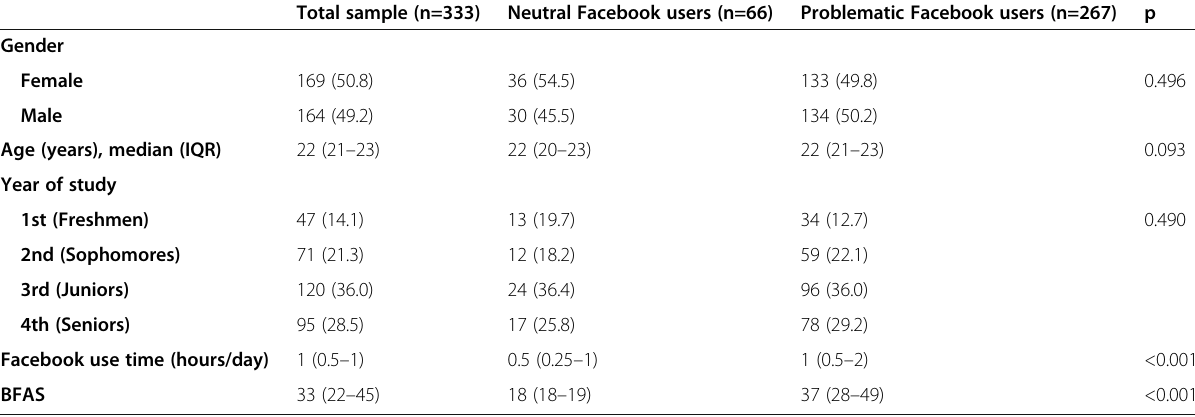
Table 1 Characteristics of the